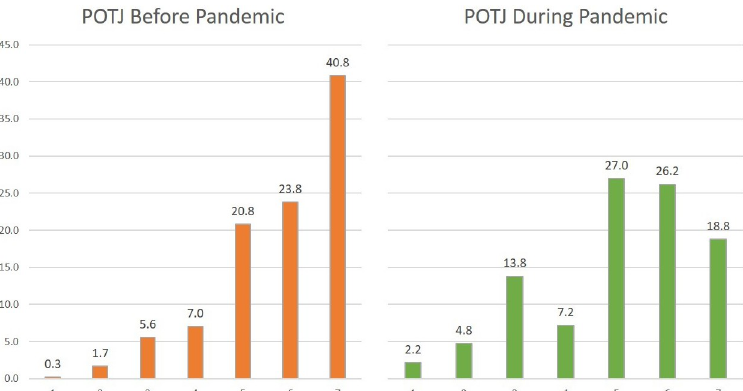
Fig 1. Proportions of selected options (in percents) for passage of time judgments (POTJs) for the preceding year from data gathered before the pandemic (POTJs Before) and during the pandemic (POTJs During). Values ranged from 1 = very slow to 7 = very fast